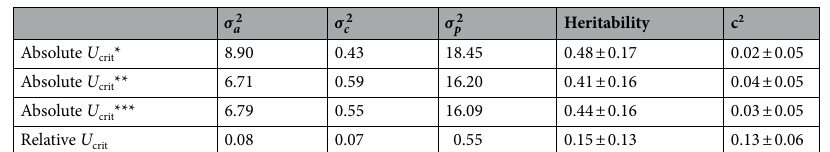
2 σ 2 σ 2 p ), a ), common environmental variance ( c ), phenotypic variance ( 2 ) of absolute and relative critical swimming speed ( U crit ).